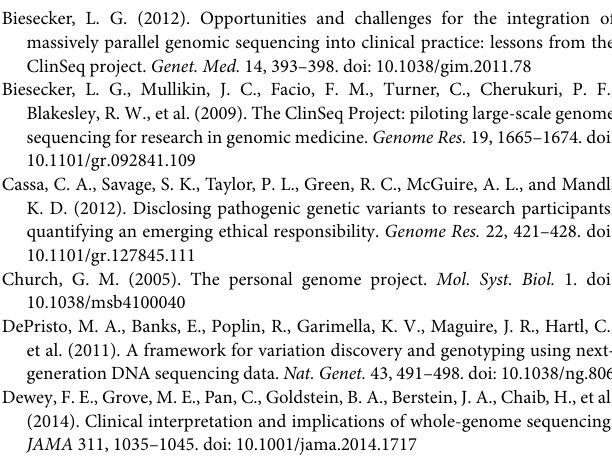
Table S10 | Genetic details for all Tier-1 SNVs. Table S11 | Genetic details for all Tier-1 indels. Table S12 | Genetic details for all Tier-2 SNV. Table S13 | Genetic details for all Tier-2